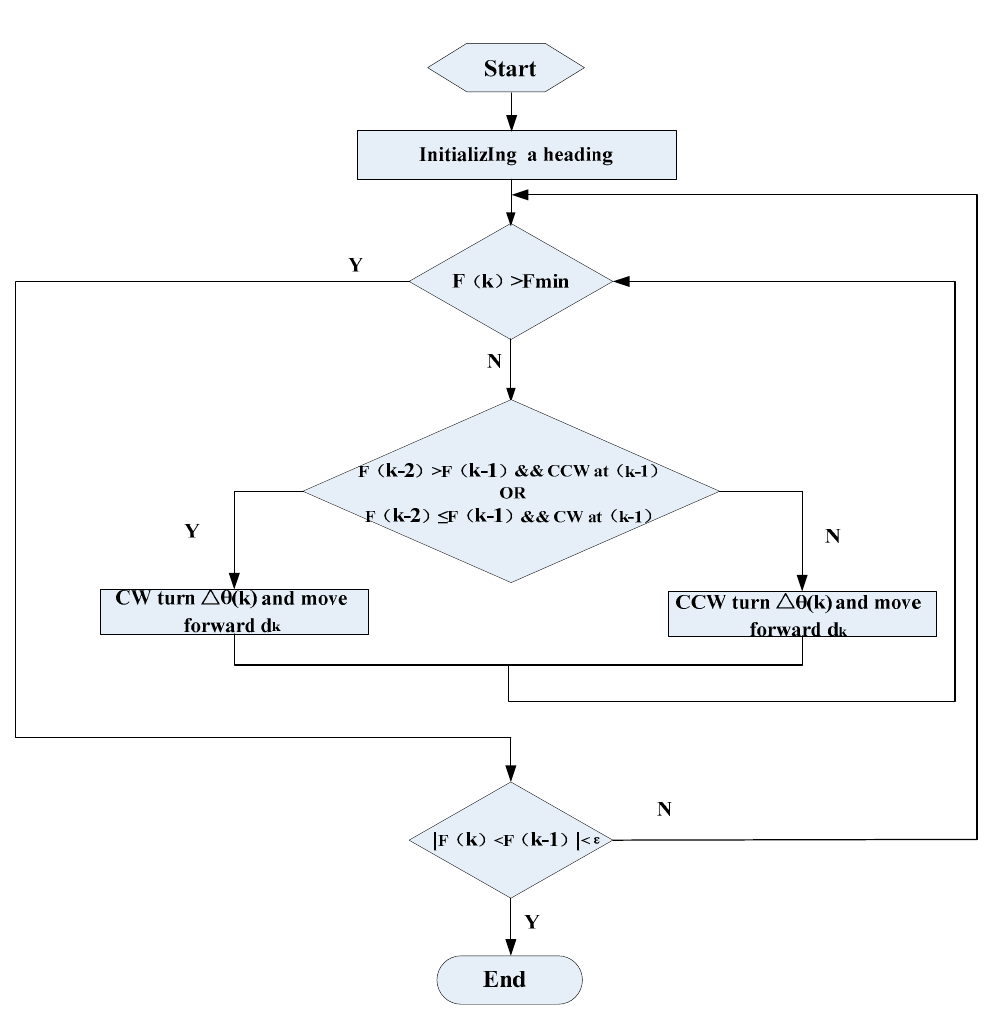
Figure 6. Flow diagram of the searching algorithm.